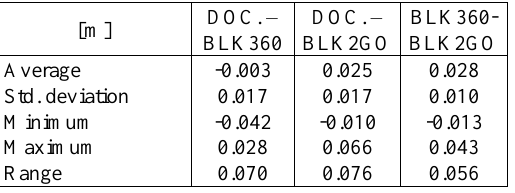
Table 5 . Comparison of wall thickness (number of